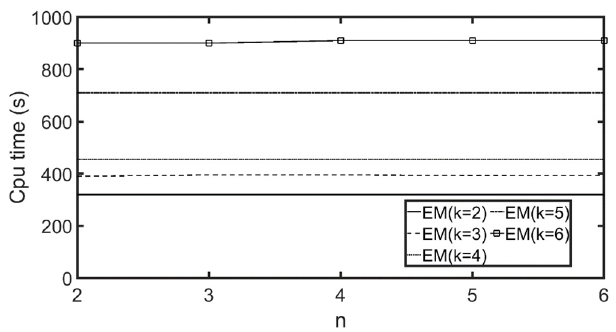
Figure 16. Computation time for customer similarity scores with ( α k = 4, α n = 4, CAL).